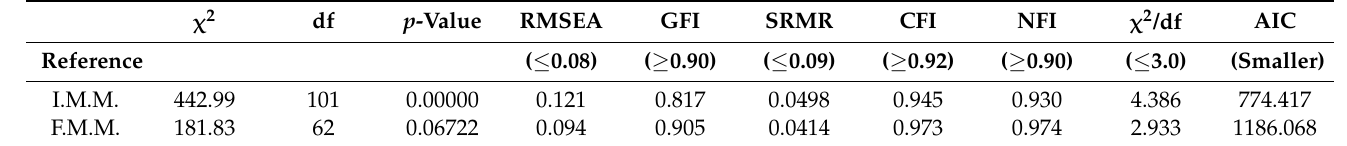
Table 7. Goodness-of-Fit Indicators of the Final Measurement Model regarding Causes of Churning